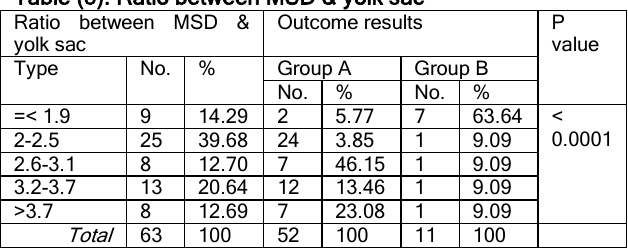
The MSD:YS ratio was significantly different between group A and group B.The majority of the patients in the group B demonstrated a ratio of 1.9 or less (7 out of 11), while 50 patients in group A demonstrated a ratio of > 2 Table (3): Ratio between MSD & yolk sac Ratio between MSD & Outcome yolk sac